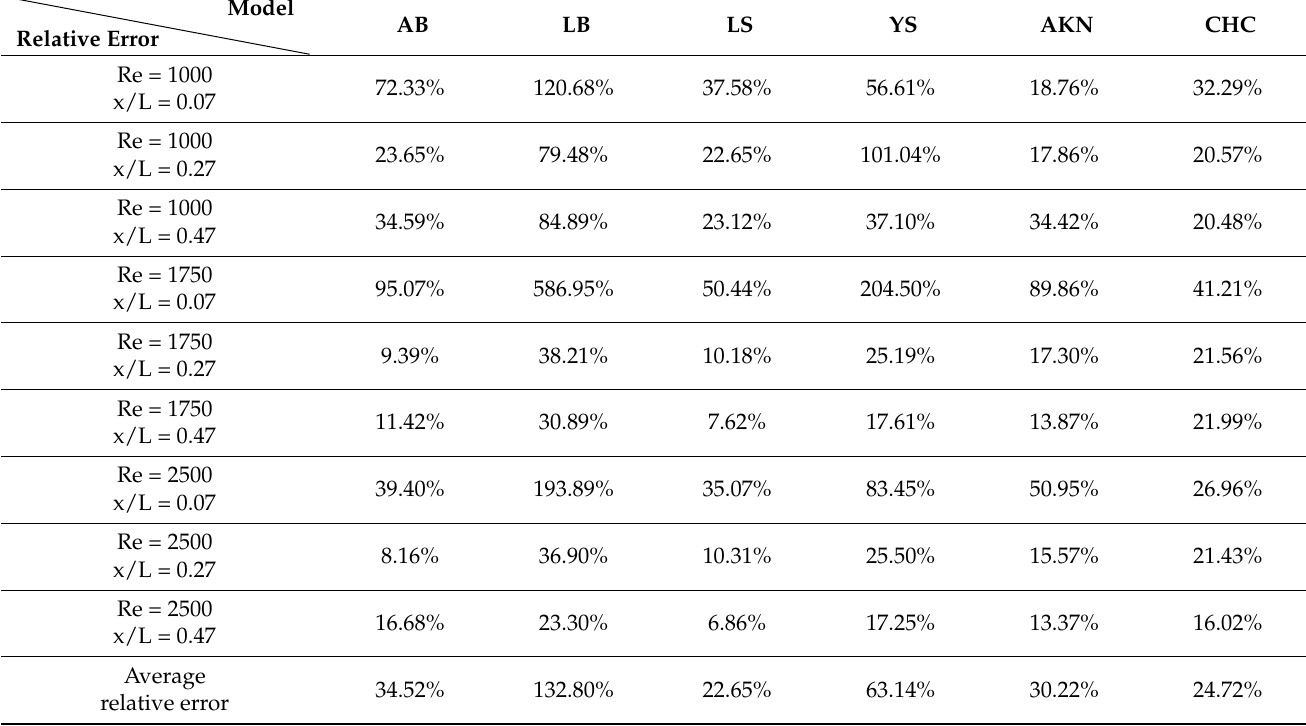
Table 4. Relative error of mean velocity predicted by six low-Reynolds number k- ε